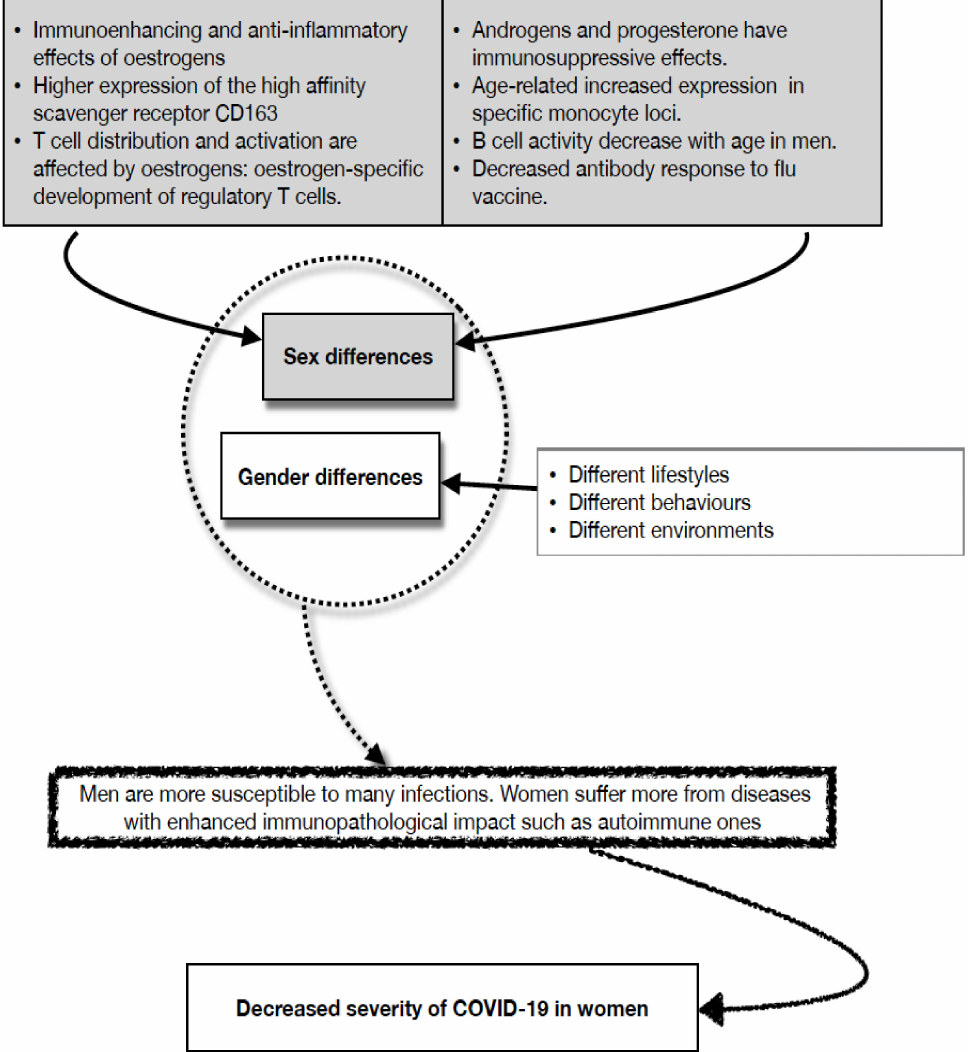
Figure 1. Immune responses differ in men and women The strength and the kind of immune responses are different between males and females (for the references see